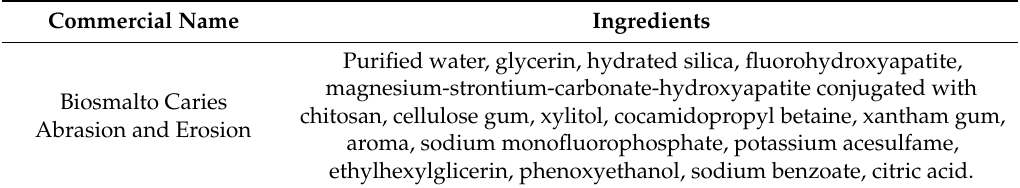
Table 1. Ingredients list of the test